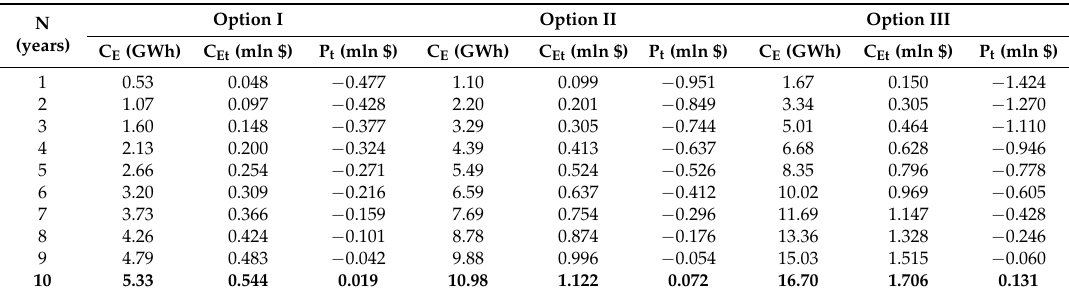
Table 8. ESD total cost and profit for a 10-year